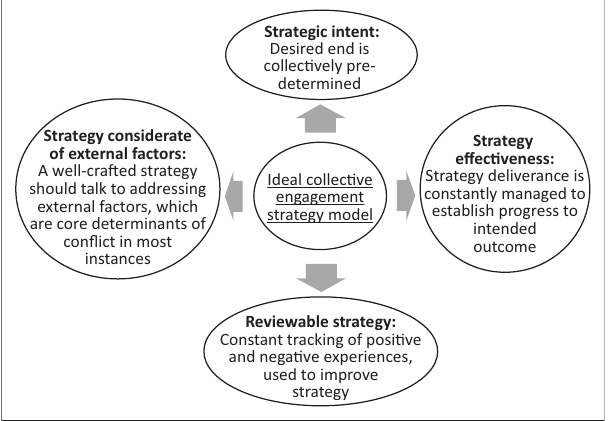
FIGURE 2: Proposed collective engagement strategic